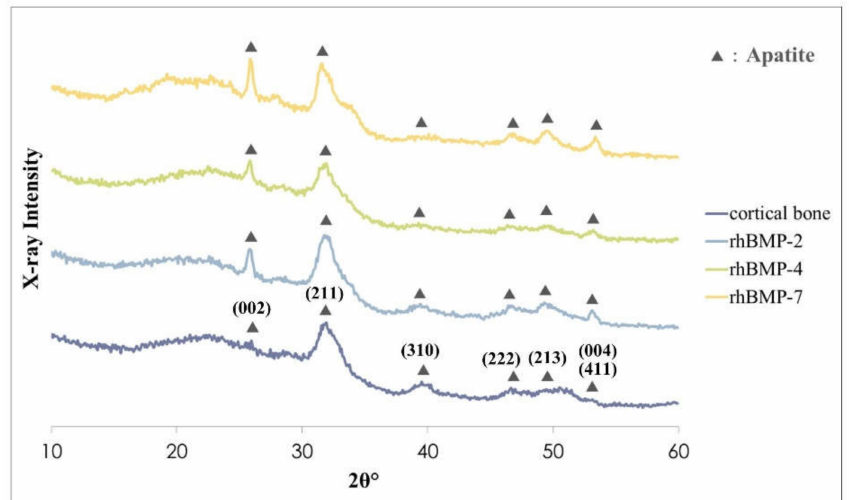
Figure 3. XRD patterns of rhBMP-2, rhBMP-4, and rhBMP-7 samples two weeks after cultivation and rat calvarial cortical bone. Black triangles show typical apatite peaks and their crystal planes were indexed according to JCPDS card